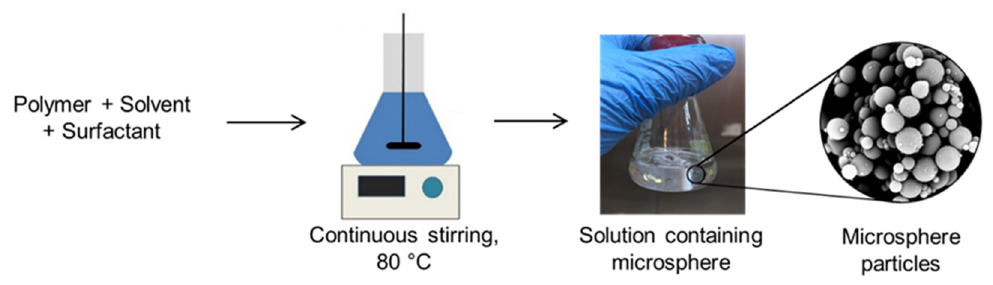
Figure 1. Schematic diagram of the synthesis of microspheres template via solvent evaporation method.